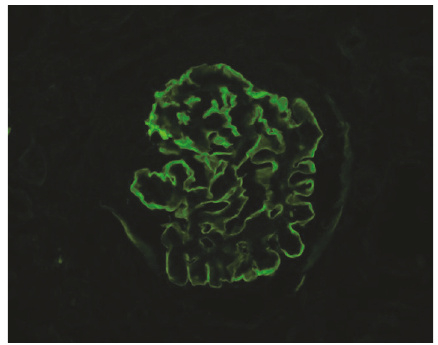
Figure 4: Immunofluorescence showing linear IgG